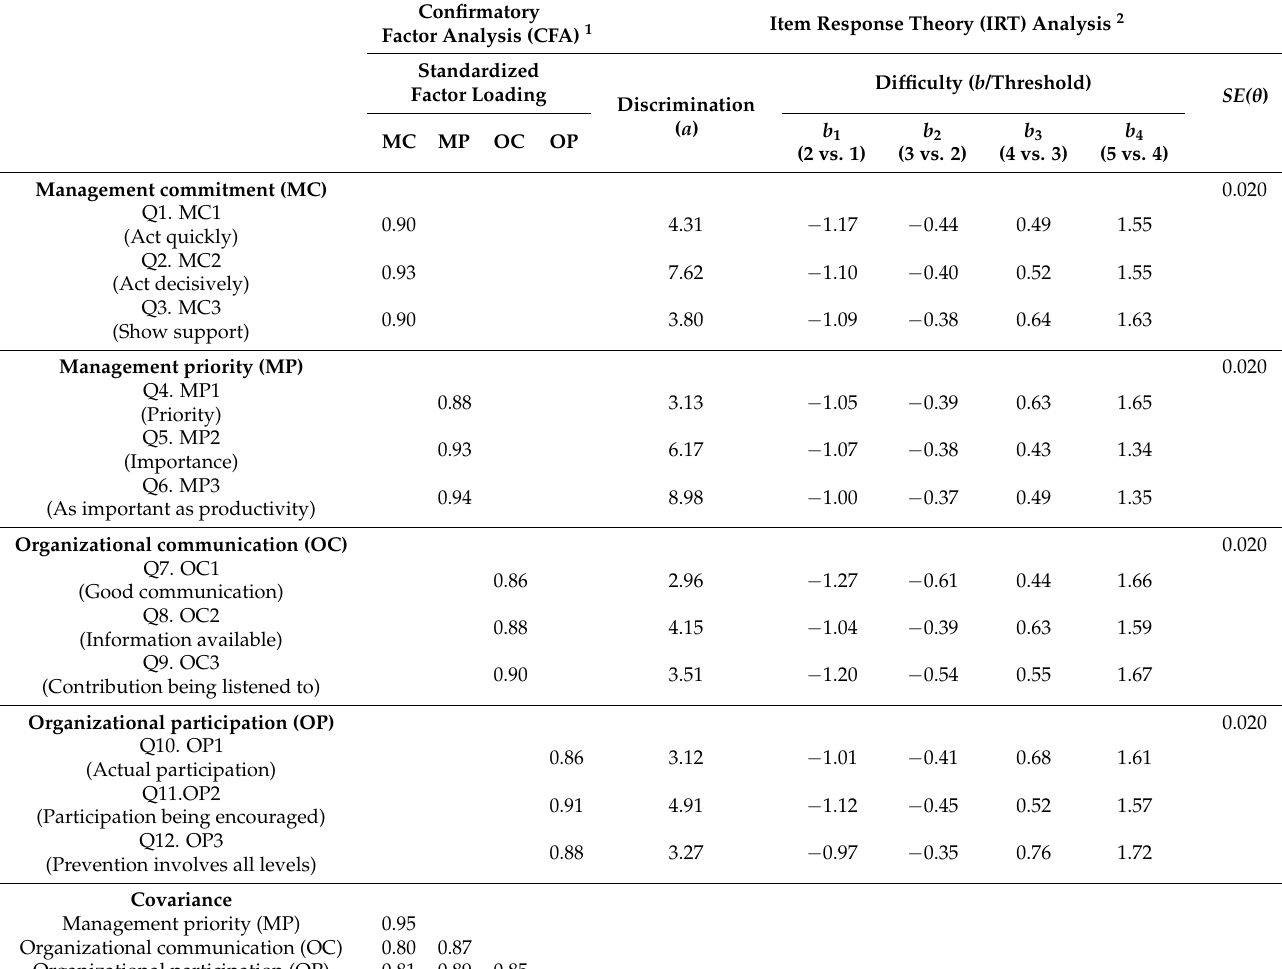
Table 3. Confirmatory factor analysis (standardized factor loading of items in the four-factor structure and covariance among factors) and item response theory analysis (discrimination and difficulty of items and standard error of the theta ( SE ( θ )) in each subscale) of the PSC-12J ( N =